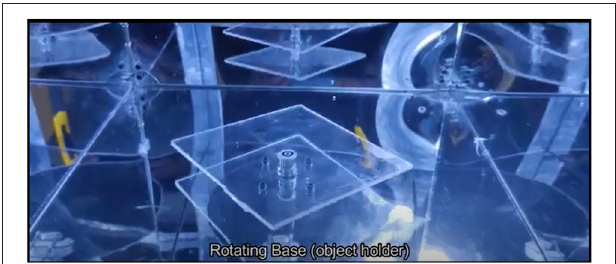
FIGURE 14 | Device internal view - rotating base.